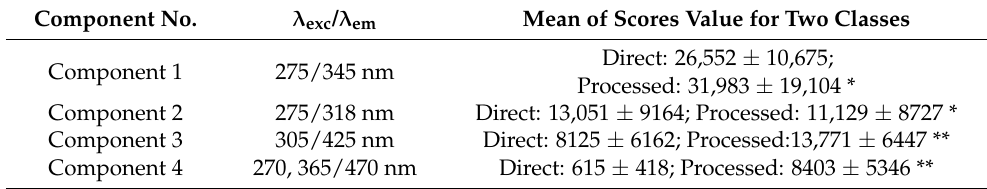
Table 1. Results of parallel factor analysis (PARAFAC) of EEMs of strawberry beverages. Component No. λ exc / λ em Mean of Scores Value for Two Classes Direct: 26,552 ± 10,675; Component 1 275/345 nm Processed: 31,983 ± 19,104 * Component 2 275/318 nm Direct: 13,051 ± 9164; Processed: 11,129 ± 8727 * Component 3 305/425 nm Direct: 8125 ± 6162; Processed:13,771 ± 6447 ** Component 4 270, 365/470 nm Direct: 615 ± 418; Processed: 8403 ± 5346